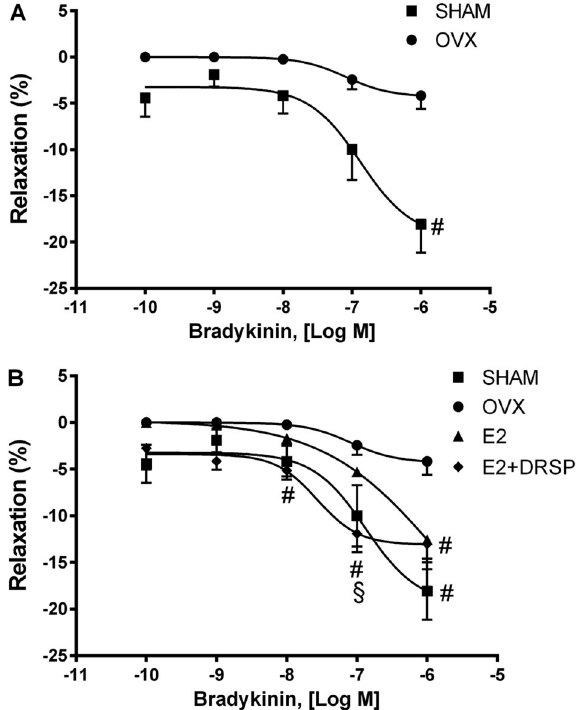
Figure 1. Endothelium-dependent coronary vasodilation with bradykinin. Vasodilation caused by estrogen de fi ciency ( A ). Effects of E2 and E2 + DRSP treatments on coronary vascular function ( B ) in ovariectomized spontaneously hypertensive rats. Data are reported as means ± SE (n=5 – 6 per group). OVX: ovariectomized; E2: estrogen; DRSP: drospirenone. # P o 0.05 compared to OVX, y P o 0.05 compared to E2 (two-way ANOVA followed by Tukey ’ s post hoc test).